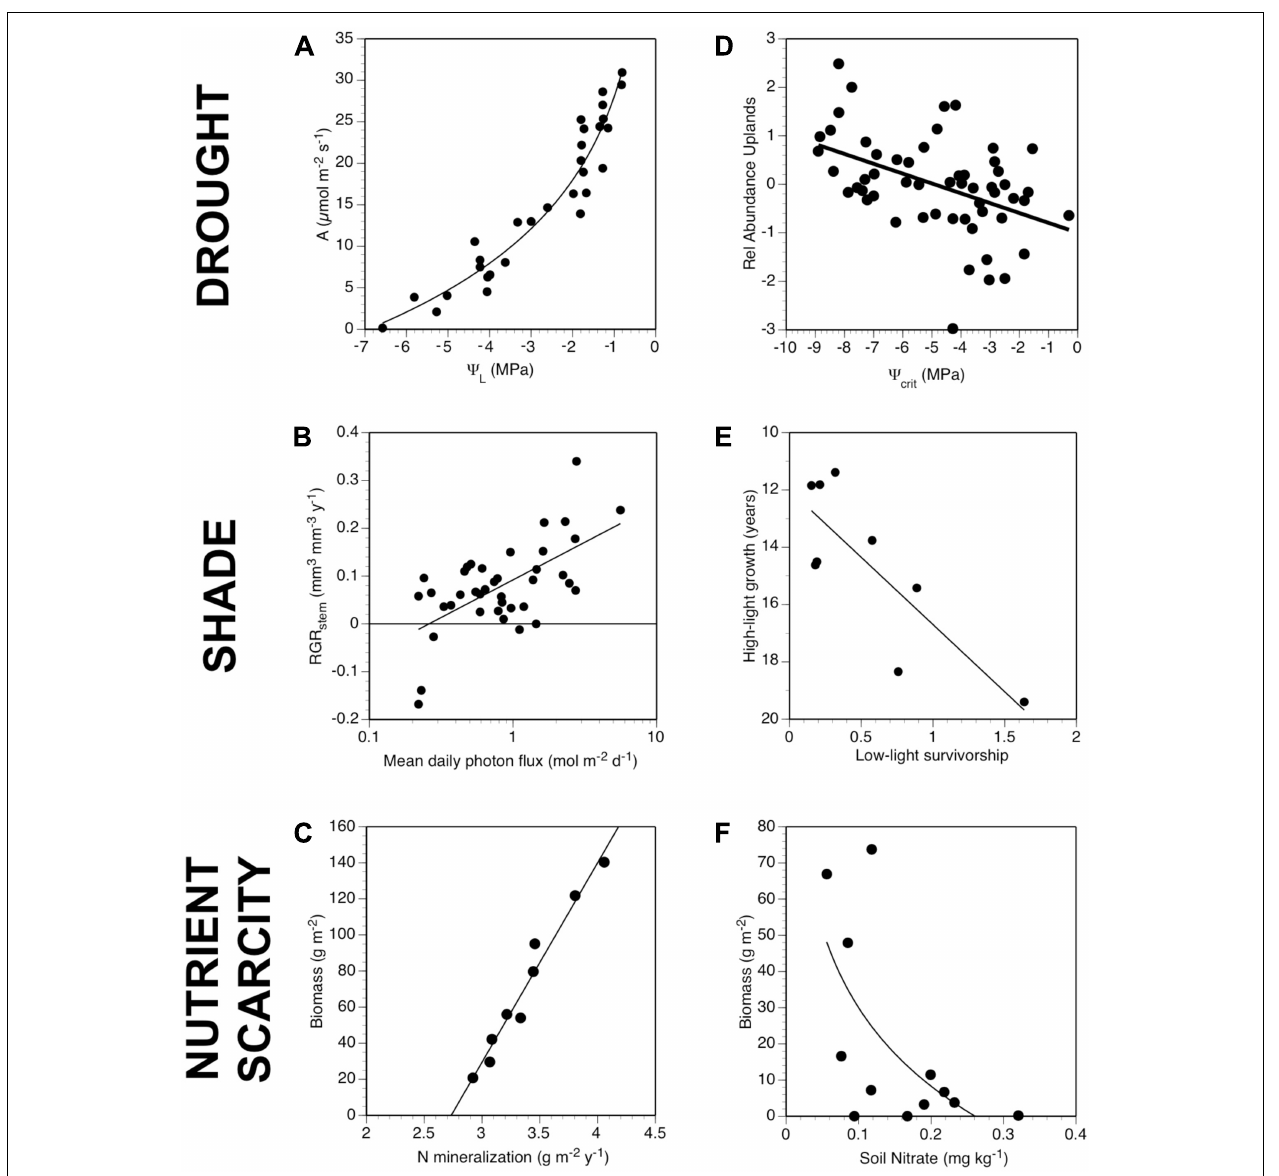
FIGURE 3 | Parallel patterns for drought, shade, and nutrient scarcity of generating and applying low resource tolerance traits. The first column (A–C) shows examples of response curves for water (photosynthetic rates vs. leaf water potential for a C 4 grass; Baruch etal., 1985), light (relative growth rate of stems vs. irradiance for a temperate understory tree; Lusk, unpublished), and nutrient availability (growing season biomass vs. nitrogen mineralization rates for a C 3 grass across a gradient of soils with different soil organic matter levels;Wedin andTilman, 1990;Wedin andTilman, 1993).The